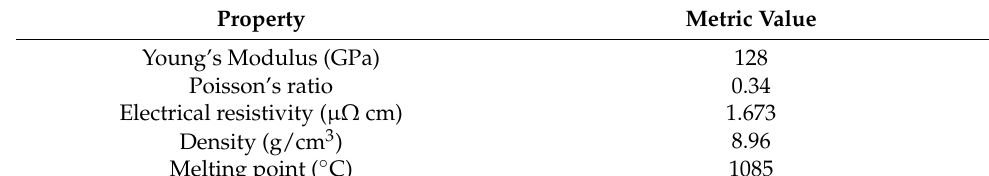
Table 2. Properties of the copper electrode.